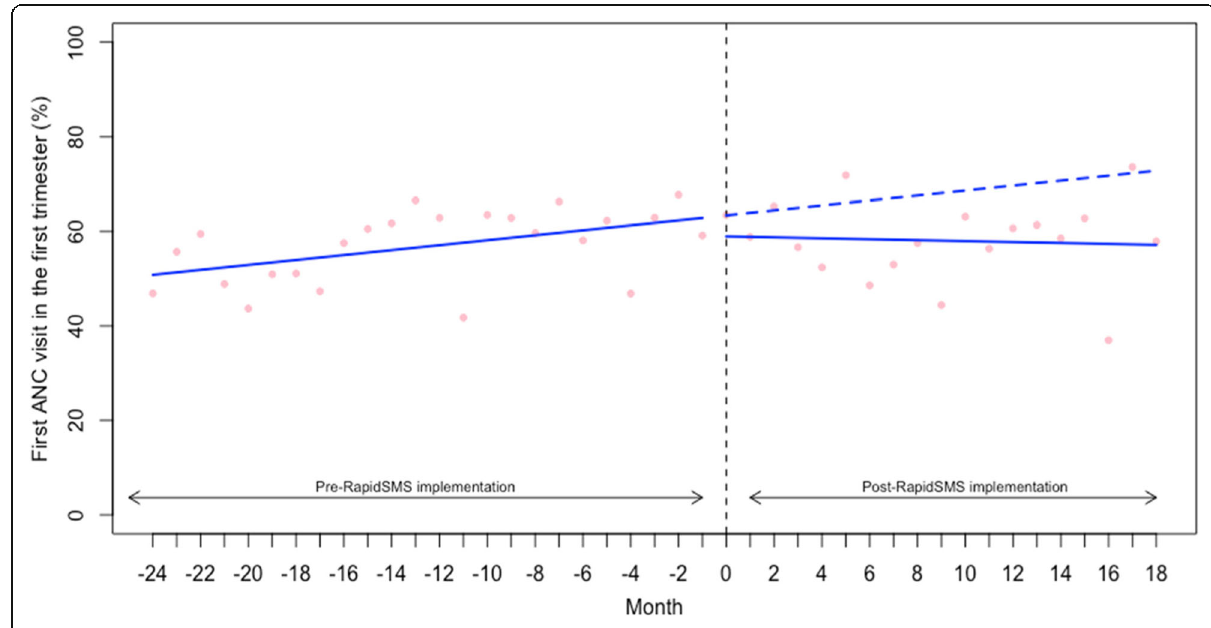
Fig. 3 Interrupted time series analysis of antenatal care (first visit in the first trimester)